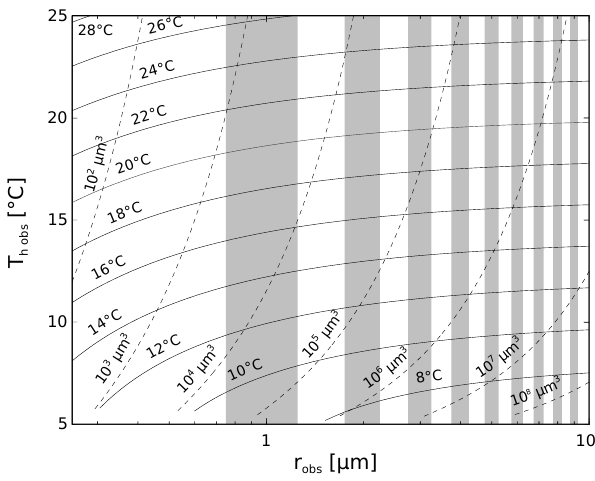
Figure 4. Error limit in T h ∞ due to an underestimation of the ra- dius by 0.25µm, as a function of the bubble radius for different T hobs of 6, 10, 16 and 20 ◦ C.